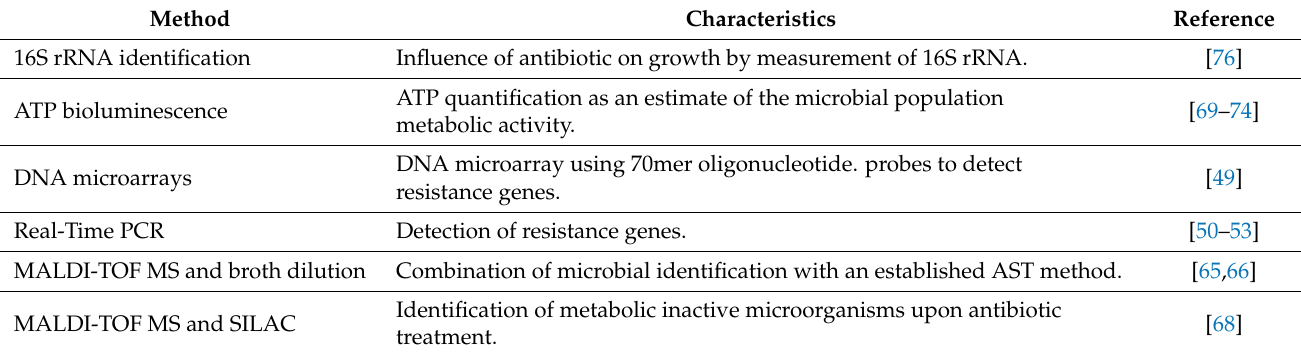
Table 2. Molecular AST methods. SILAC: stable isotope labeling by amino acid in cell